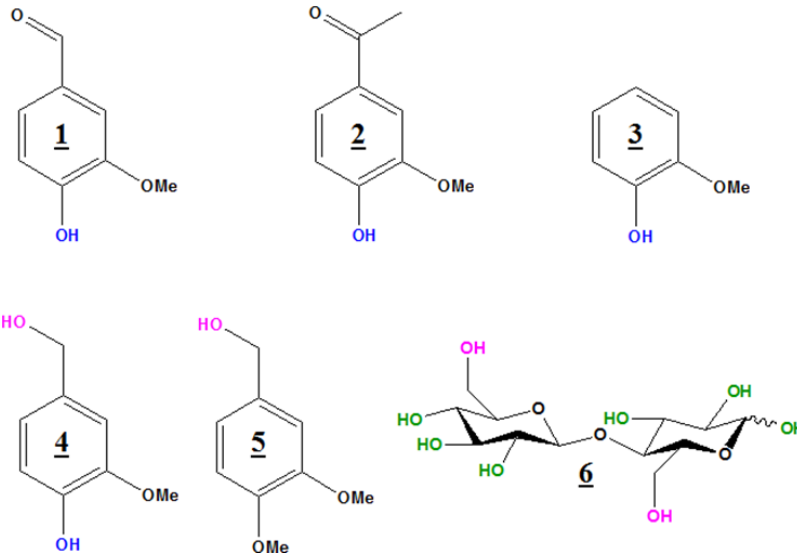
Figure 2. Studied model compounds: Vanillin ( 1 ), Acetovanillone ( 2 ), Guaiacol ( 3 ), Vanillyl alcohol ( 4 ), Veratryl alcohol ( 5 ) and D( + ) Cellobiose ( 6 ).